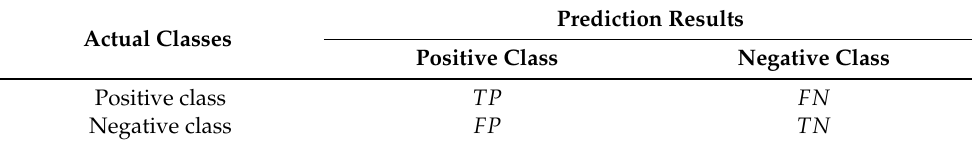
Table 5. The confusion